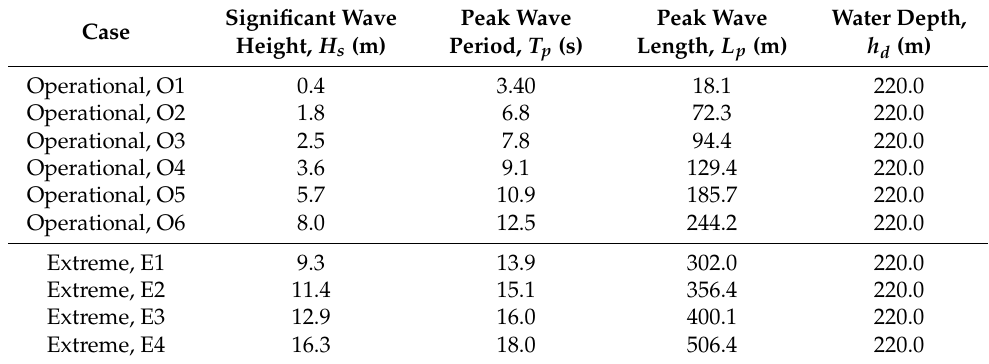
Table 2. Definition of environmental conditions for the 10 cases.